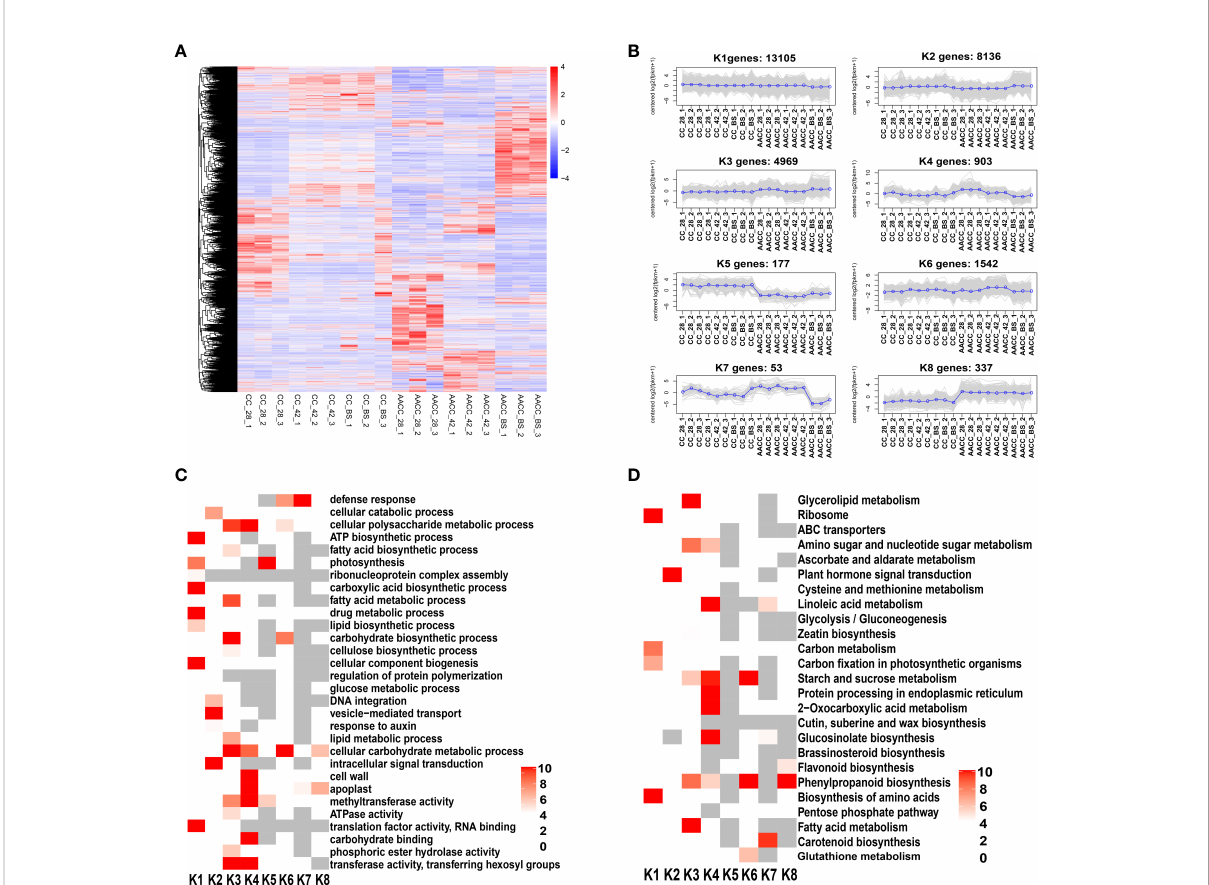
FIGURE 4 Comprehensive analysis of total DEGs in stems of CC and its AACC. (A) Heatmap of DEGs across three stem developmental stages in CC and AACC. Expression values of six libraries were presented as FPKM normalized log2 transformed counts. Red and blue colors indicate up- regulated and down-regulated transcripts, respectively. (B) Expression patterns of the genes in the eight main clusters, namely K1-K8, corresponding to the heatmap. (C) GO-term function and KEGG enrichment analysis of different clusters. (D) KEGG enrichment analysis of different clusters. The signi fi cances of the most represented GO-slims and KEGG in each main cluster are indicated using log-transformed P- value (red). The dark grey areas represented the missing